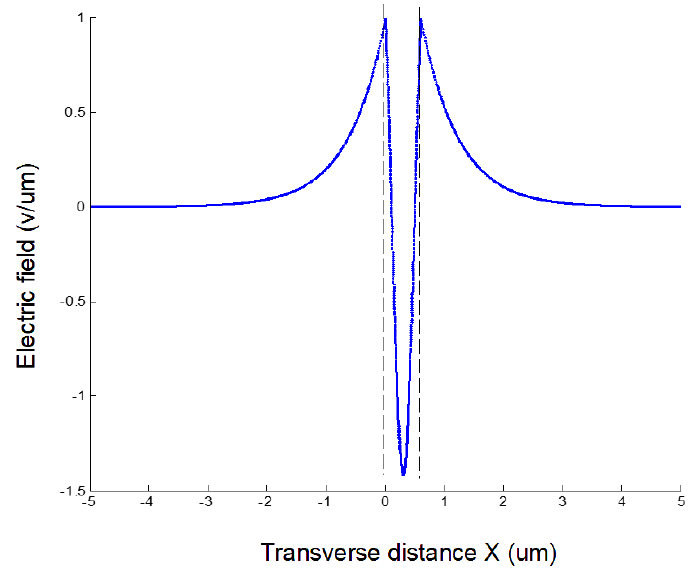
Figure 14. The electric field distribution at α c, s = 0 with d f = 0.593 μ m.